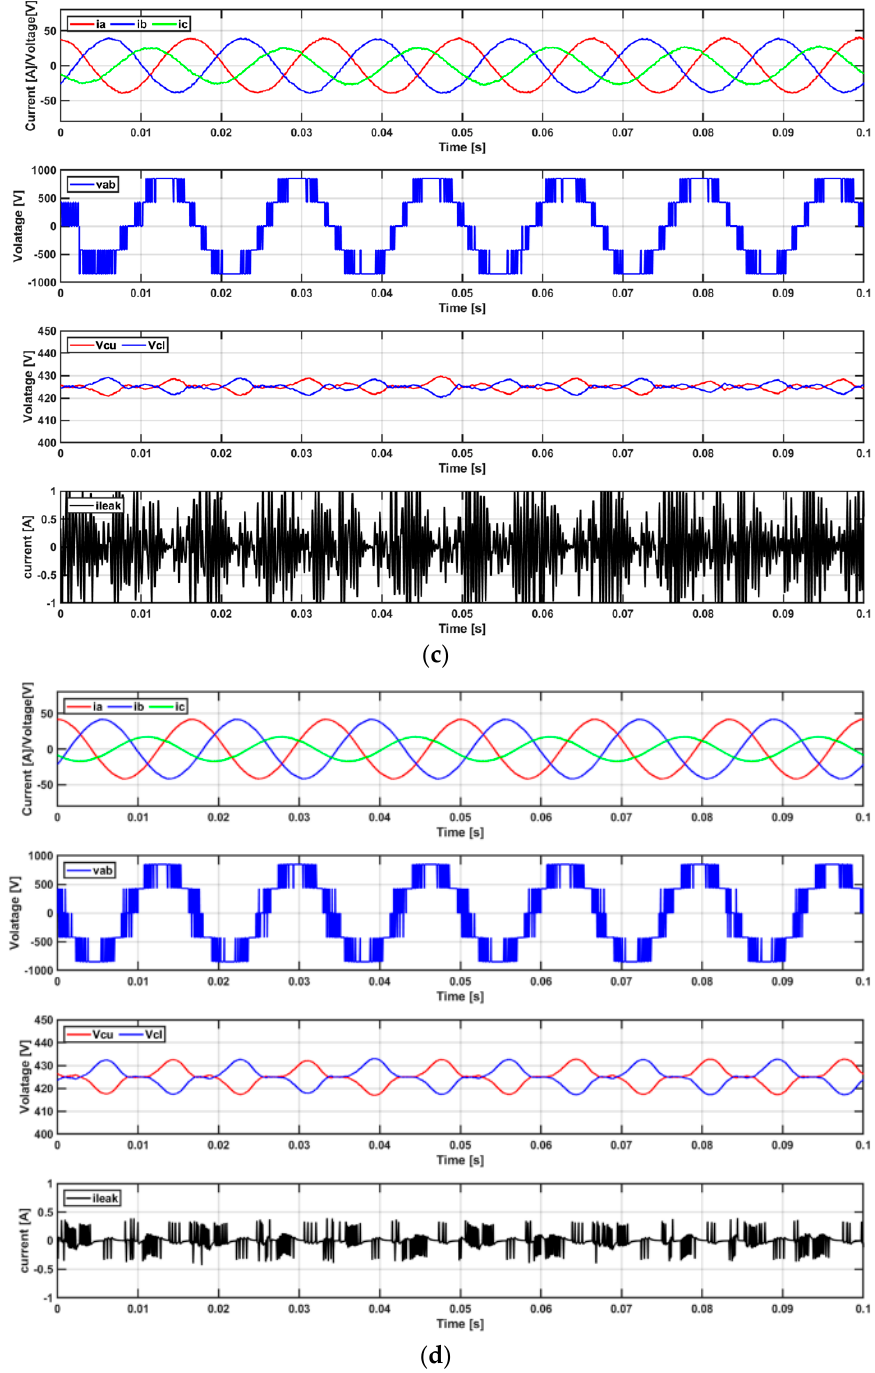
Figure 6. Comparison of output performance of a four-leg inverter (output current, output line voltage, DC voltage, leakage current) in unbalanced load conditions: ( a ) two-level three-leg four-wire type, ( b ) two-level four-leg type, ( c ) three-level three-leg four-wire type, and ( d ) three-level type four-leg inverter.